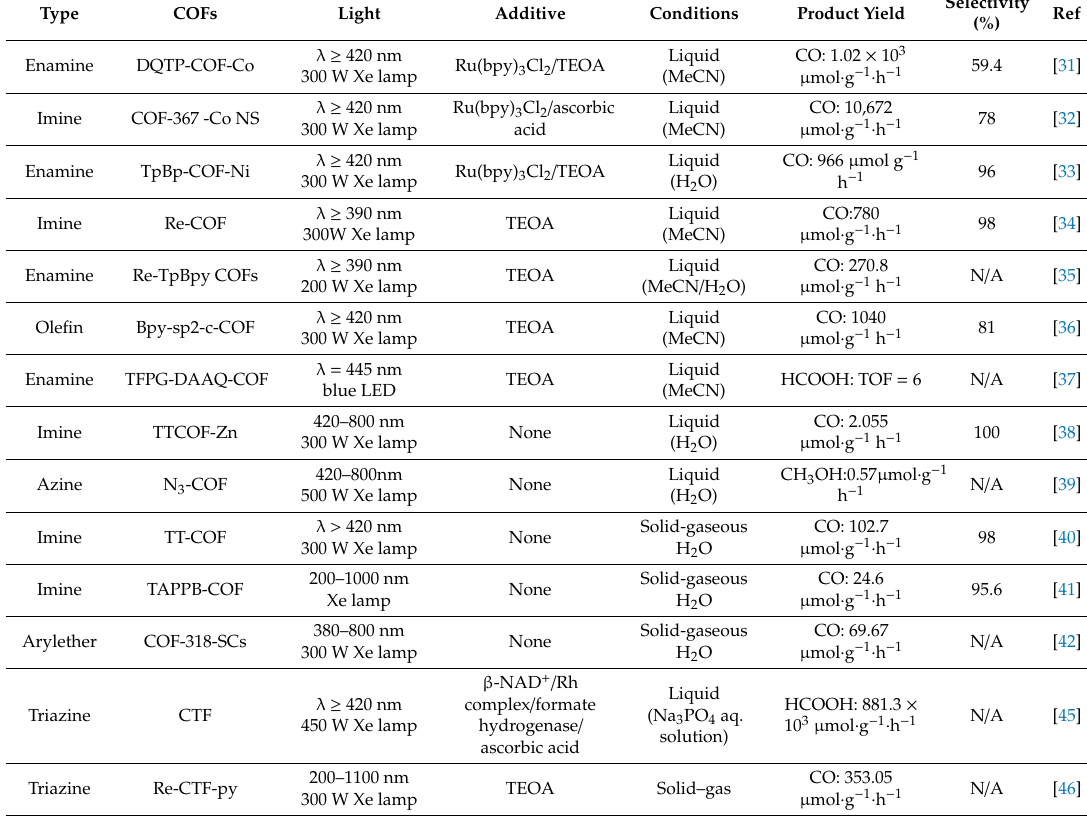
Table 2. The summary of photocatalytic CO 2 reduction performance for COFs with di ff erent structure.